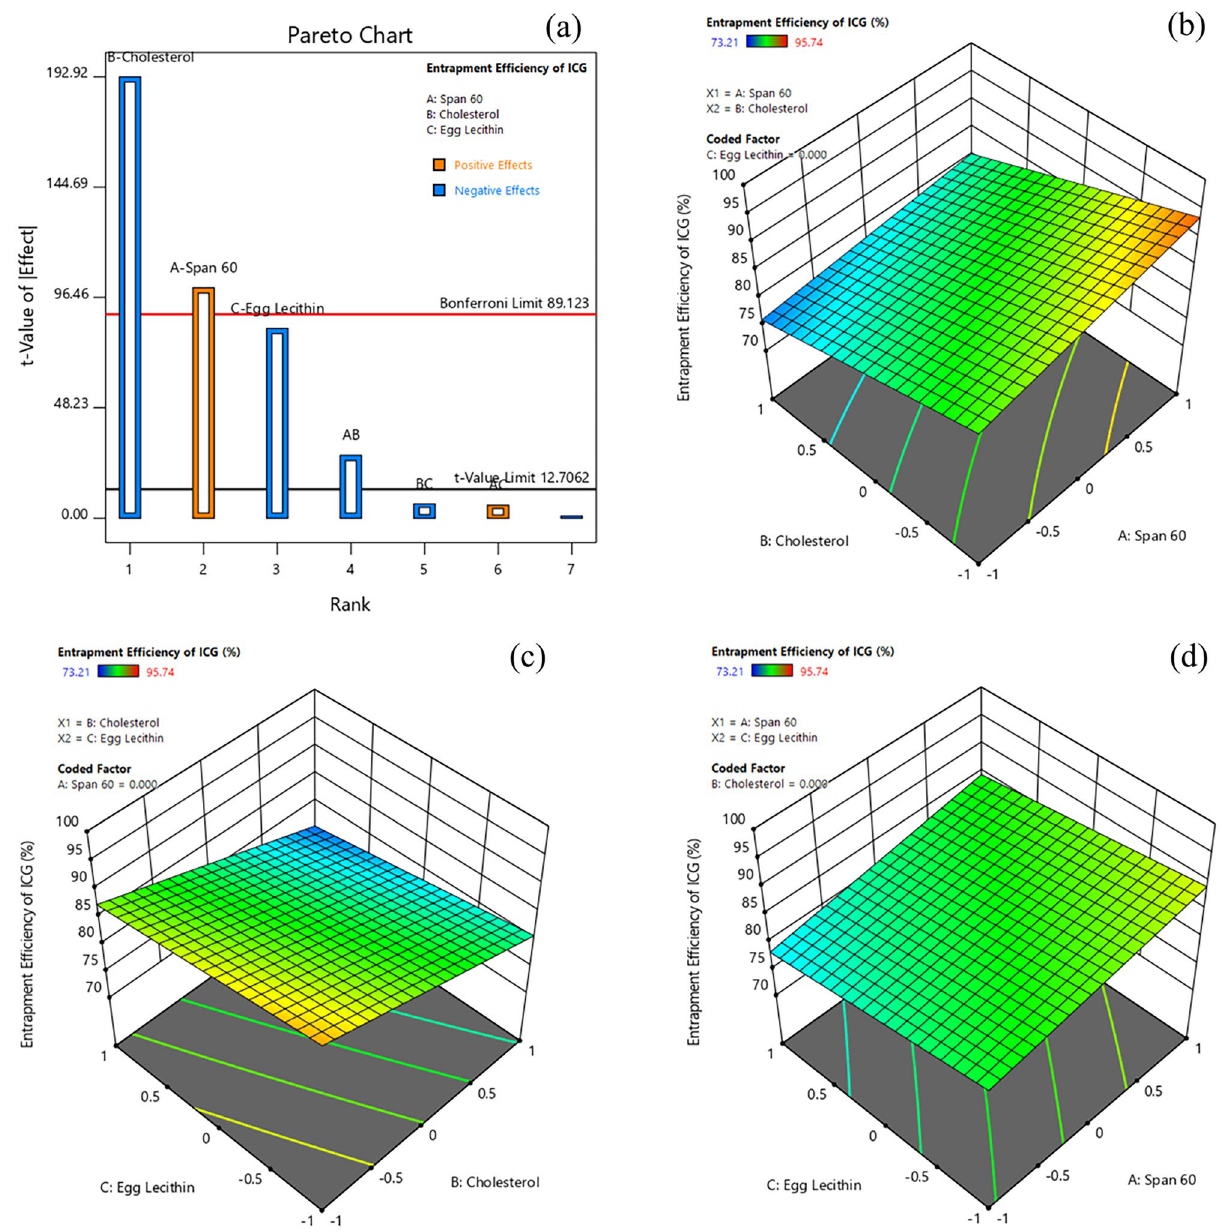
Figure 5. Effect of formulation variables ( a ) Pareto chart of Entrapment Efficiency (EE) of ICG, ( b ) Span60*Cholesterol on EE of ICG, ( c ) Cholesterol* Egg Lecithin on EE of ICG, ( d ) Span60*Egg Lecithin on EE of ICG [Design-Expert version